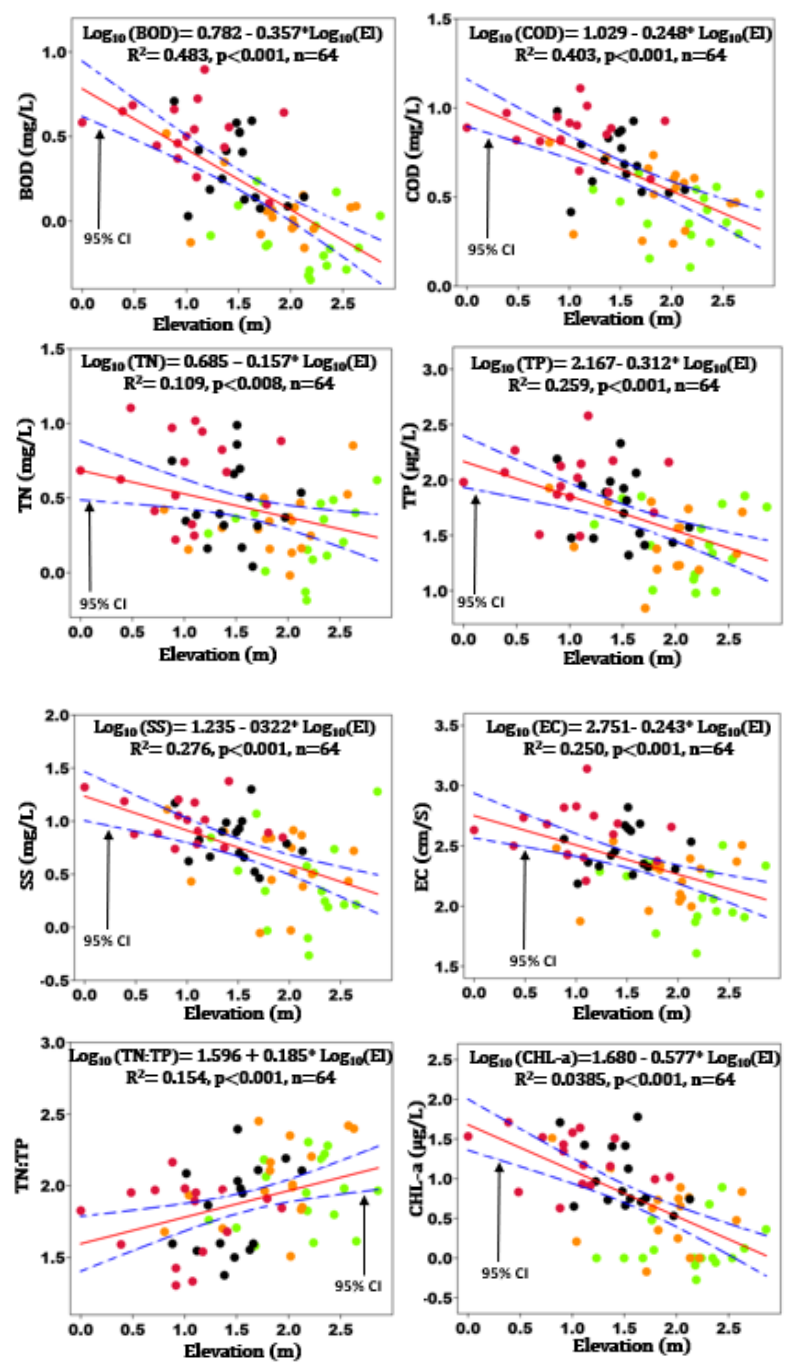
Figure 6. Regression analysis of the organic matters (BOD, COD), suspended solids (SS), electric conductivity (EC), nutrient (TN, TP), TN:TP, and Chl-a with elevation (m) in each land-use pattern (green: forest region, orange: agriculture region, black: urban upstream region, red: urban downstream region).